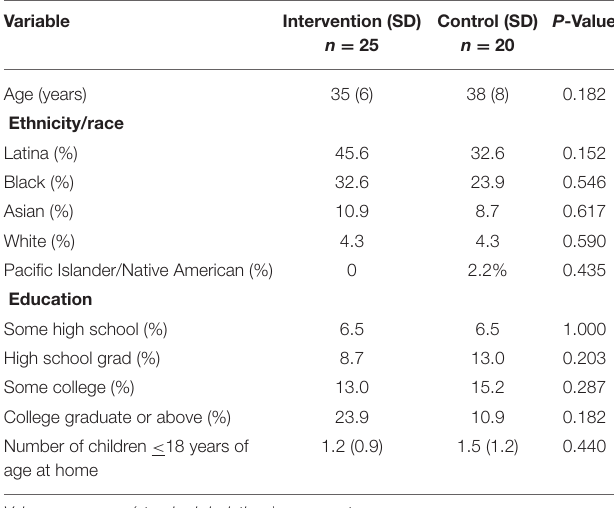
TABLE 1 | Sociodemographic characteristics of participants in a dance-movement program.